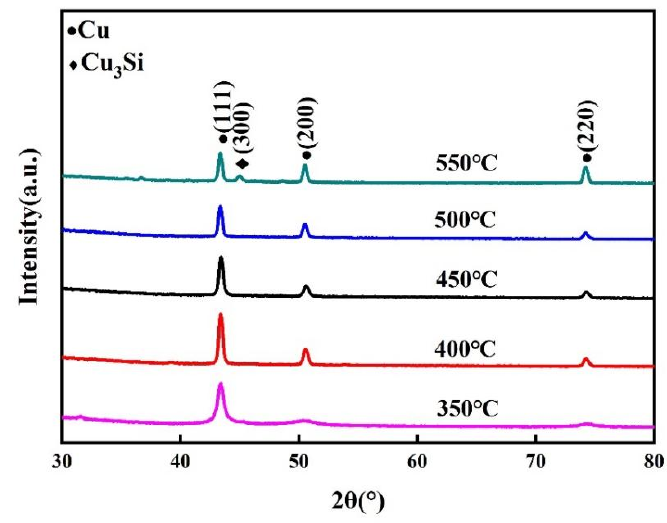
Figure 6. XRD patterns of samples after annealing at different temperatures.